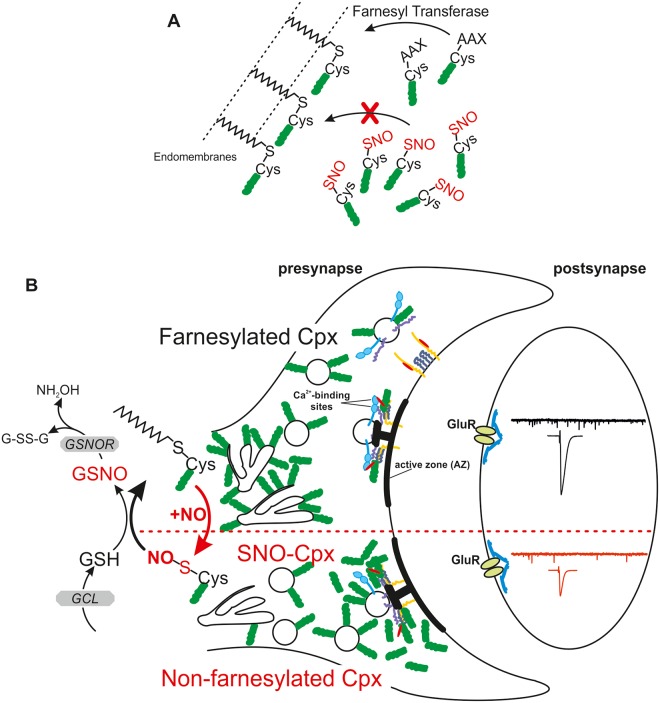
Effects of SNO formation on farnesylation and cpx function.(A) The farnesyl transferase facilitates the addition of a farnesyl group to cpx (green) containing the CAAX motif. Upon S-nitrosylation, this motif is not recognized and the protein will not be farnesylated, resulting in lack of endomembrane targeting. (B) The schematic shows the effects of S-nitrosylation of cpx Cys within CAAX, resulting in fewer proteins being farnesylated and tethered to endomembranes. This allows a greater proportion of cytosolic cpx to be able to bind to the SNARE complex (including syntaxin [yellow]/Munc-18 [red], SNAP-25 [dark purple], synaptobrevin [purple]) to compete with synaptotagmin [blue] binding and prevent fusion because of its clamping function, which results in reduced transmitter release. This process is reversible and depends on the availability of GSH-dependent de-nitrosylation of cpx. GSH is generated by GCL and GSNO is broken down into G-SS-G and NH2OH by GSNOR activity. Cys, cysteine; cpx, complexin; G-SS-G, glutathione disulphide; GCL, glutamate-cysteine ligase; GluR, glutamate receptor; GSH, glutathione; GSNO, S-nitrosoglutathione; GSNOR, S-nitrosoglutathione reductase; NH2OH, hydroxylamine; SNARE, soluble N-ethyl-maleimide-sensitive fusion protein Attachment Protein Receptor; SNO, S-nitrosothiol.